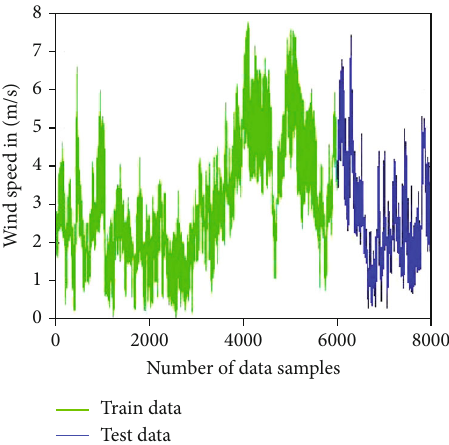
Figure 7: Data samples of the wind speed trained and tested dataset.